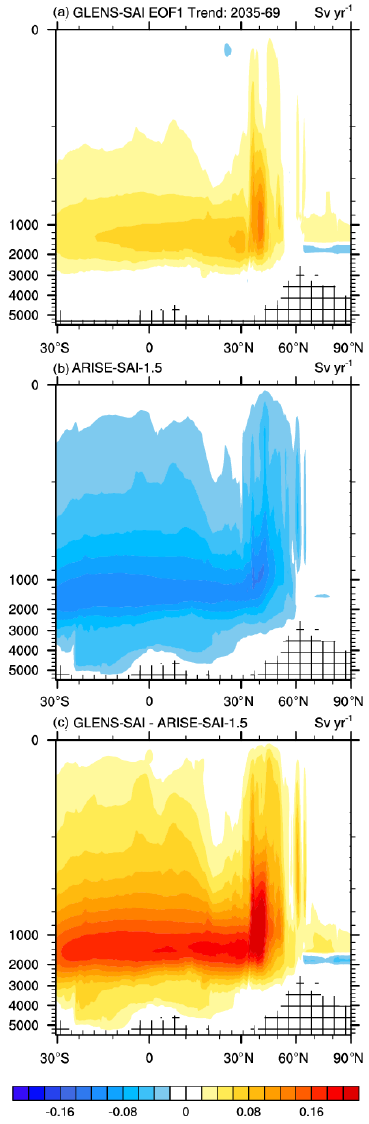
Figure A6. Latitude-depth structure of ensemble-mean changes in the leading mode of the overturning circulation scaled by the linear trend in PC1 from 2035 to 2069 for (a) GLENS-SAI, (b) ARISE- SAI-1.5, and (c) their